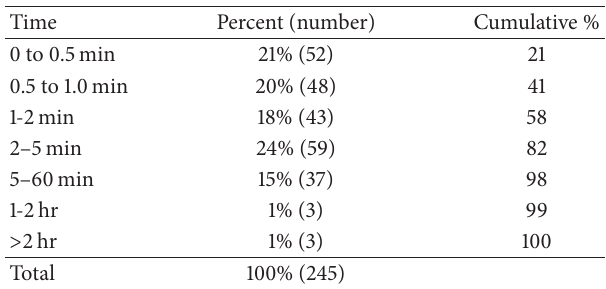
Table 2: Direction of head tremor based on breeds affected. Breed